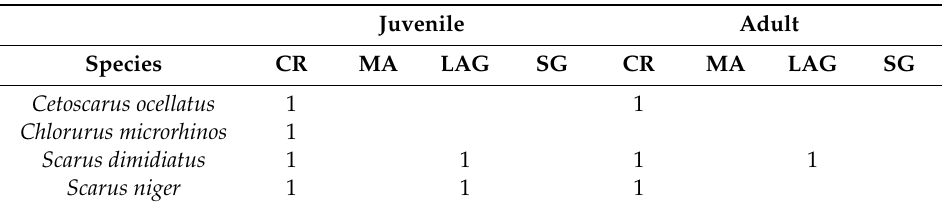
Table 4. Presence (1) from visual census in different habitats for parrotfish species with unique coloration patterns that enable confident identifications at the juvenile stage: outlined cells represent juveniles which were also identified from DNA analysis during collections in non-reef habitats. CR = Coral Reef, MA = macroalgal bed, LAG = lagoon, and SG = seagrass.